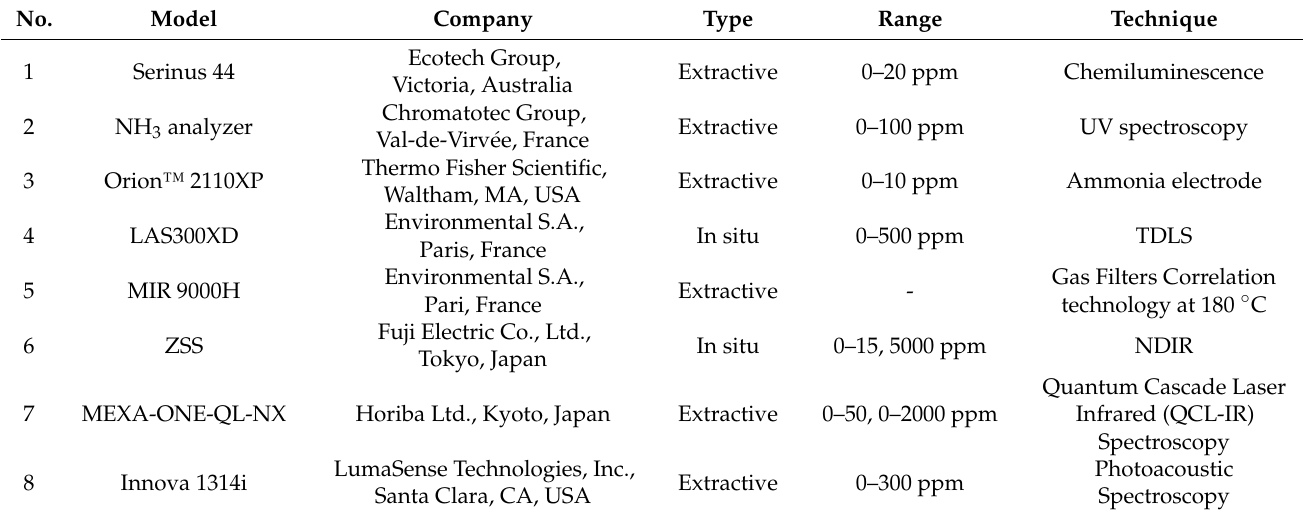
Table 1. Popular commercial NH 3